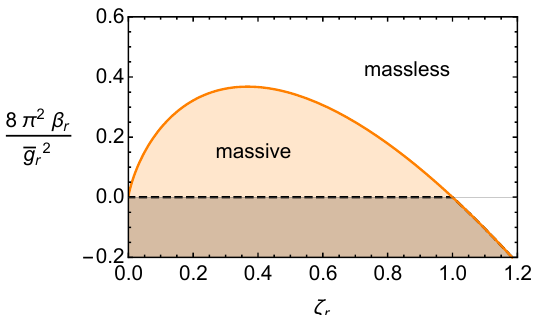
/ ¯ g 2 and r r . The shaded r